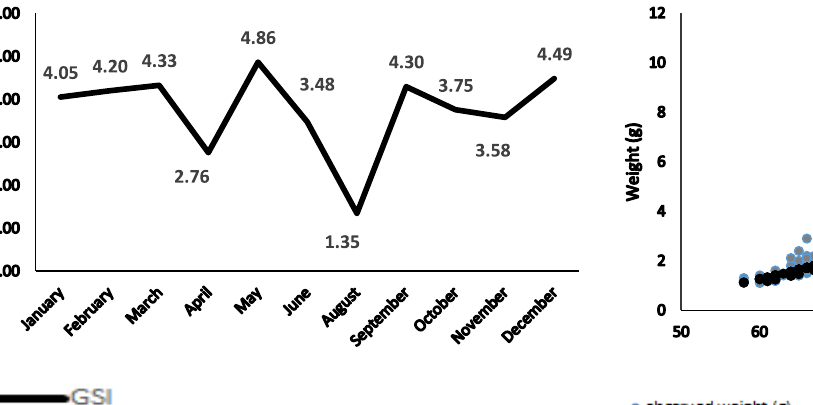
Fig. 4. Gonadosomatic index of P. stylifera females.